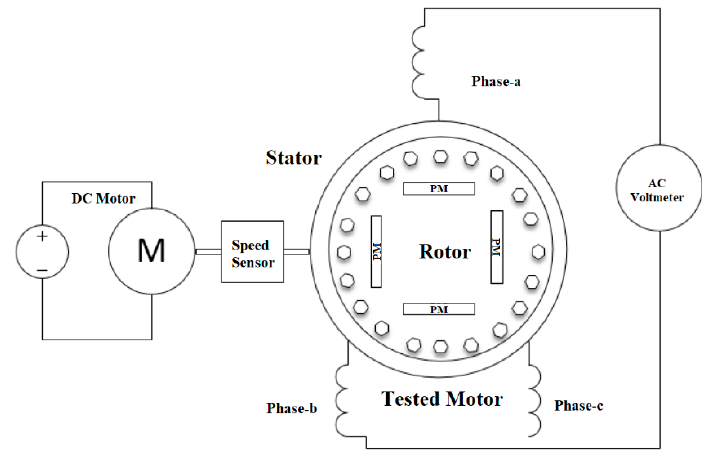
Figure 13. Open-circuit test diagram.